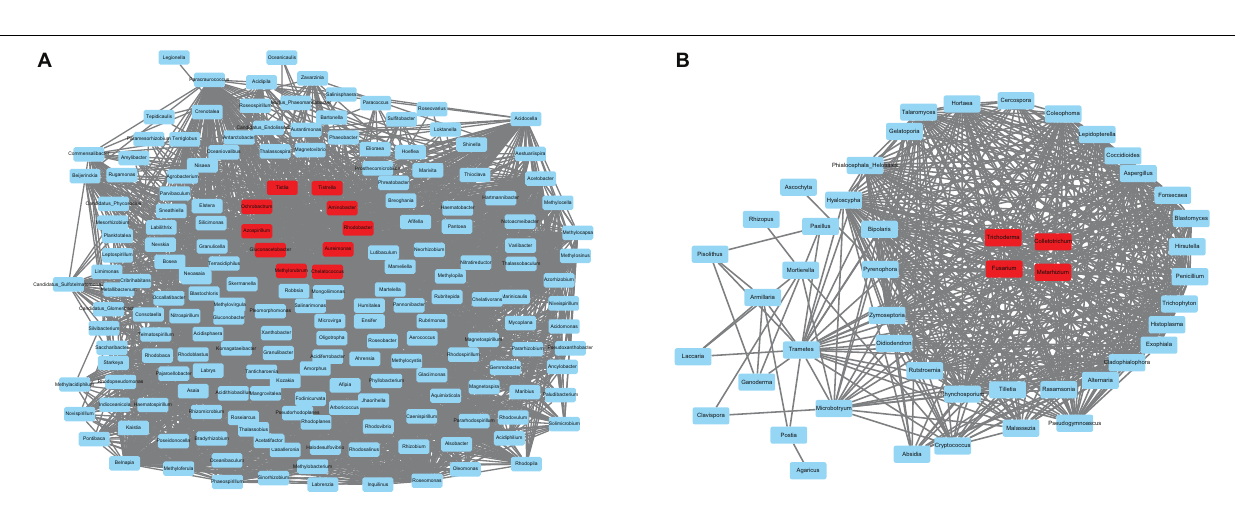
Frontiers in Microbiology |